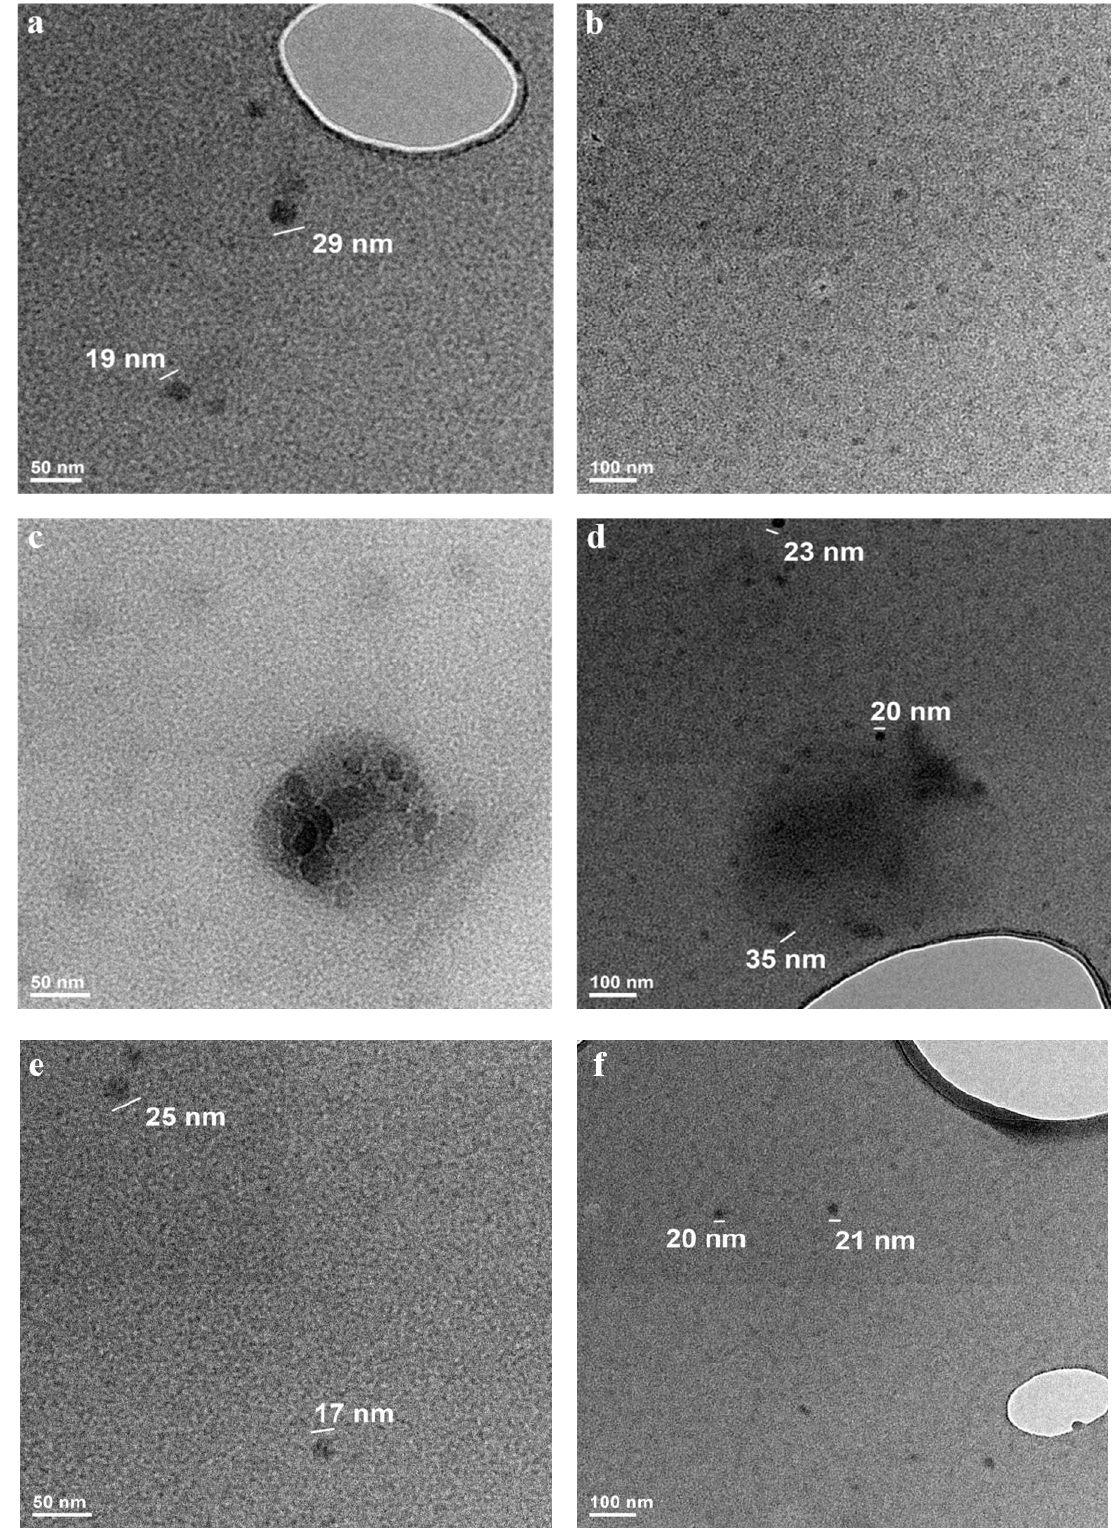
Figure 7. TEM images for individualized nanoparticles obtained from 1% sericin concentration ( a , b ); TEM images for nanoparticles aggregates obtained from 1% sericin concentration (SER 1%) ( c , d ); TEM images for individualized nanoparticles obtained from 0.1% sericin concentration (SER 0.1%) ( e,f ) .